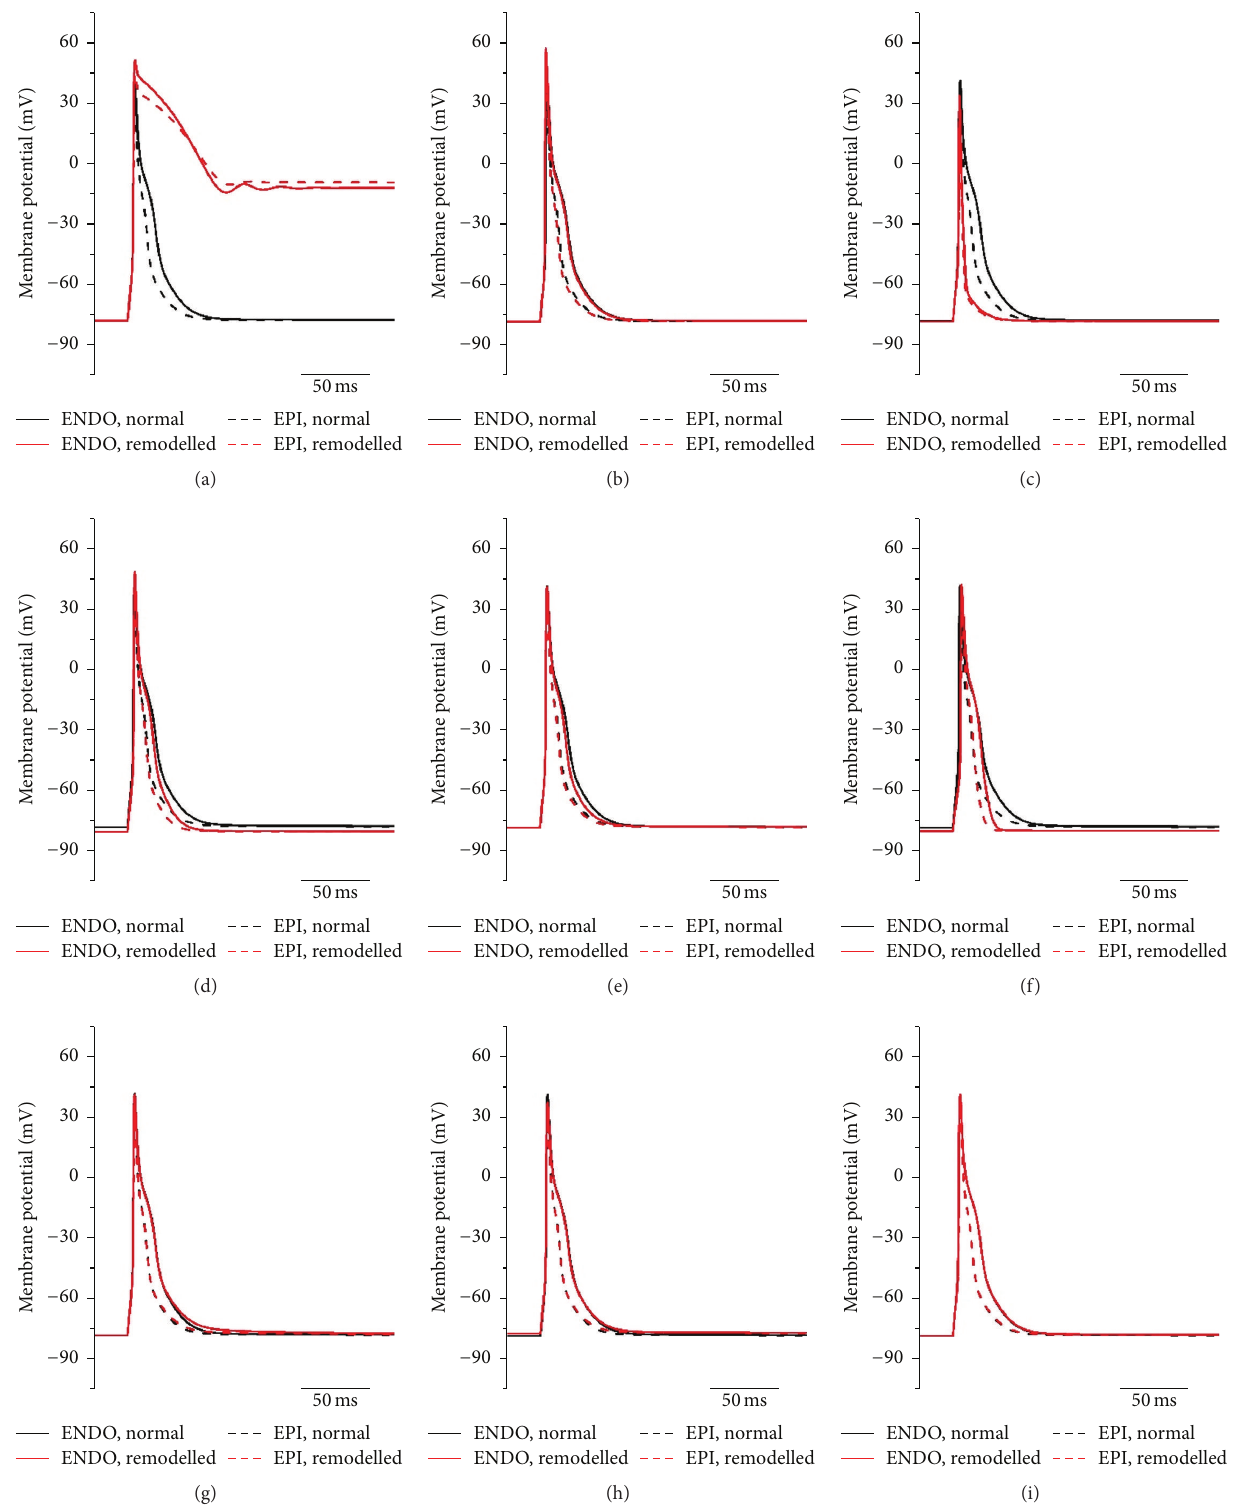
Figure6:Simulatedratventricularendocardialandepicardialactionpotentialsincontrolandobesityconditionswheneachoftheremodelled ion channels/ionic currents was modified one at a time. (a) Only 𝐼 Ca , L considered. (b) Only 𝐼 Na considered. (c) Only 𝐼 to considered. (d) Only 2+ uptake 𝐼 𝐼 𝐼 𝐼 𝐼 NaK considered. (e) Only ss considered. (f) Only K ,1 considered. (g) Only NaCa considered. (h) Only 𝑓 considered. (i) Only SR Ca and release considered ( 𝐽 Up and 𝐽 Rel ,